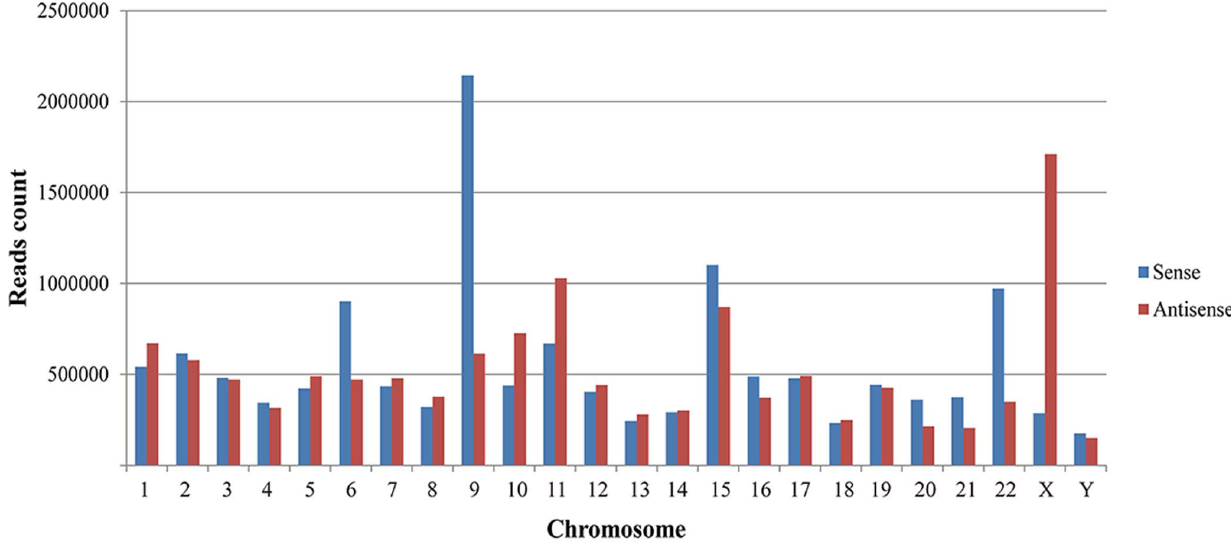
Figure 1. Number of small RNA tags that locate on each chromosome.